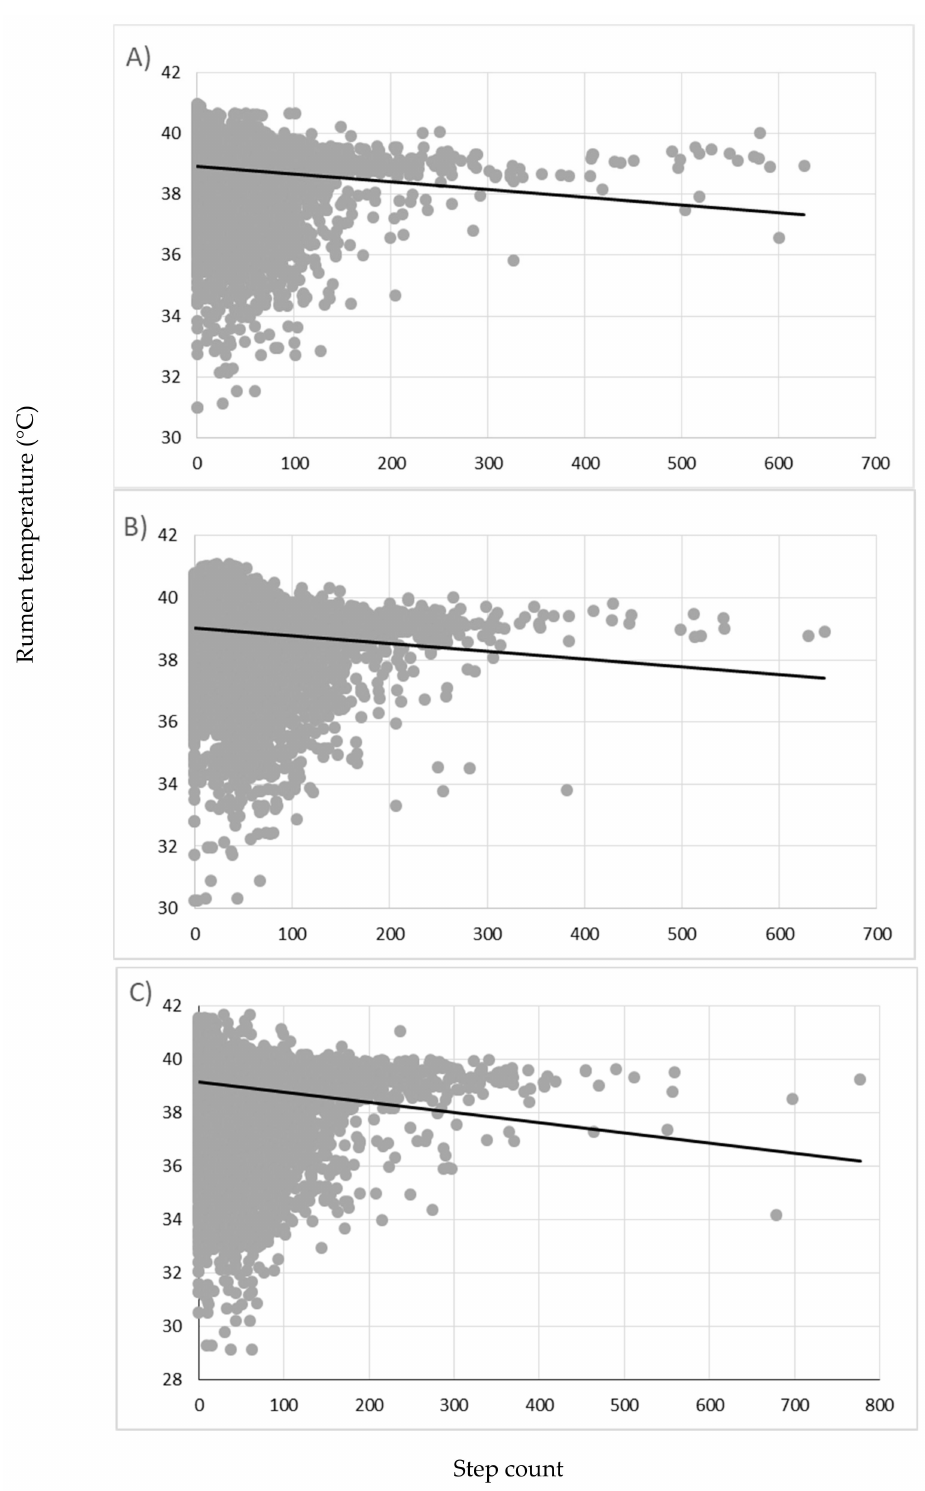
Figure 4. The e ff ect of step count on the rumen temperature of bulls on three di ff erent diets; ( A ) grazed only, ( B ) grazed with 2 kg concentrate supplementation, and ( C ) grazed with ad libitum access to concentrates. ( A ) y = -0.002534 χ + 38.85 a ( B ) y = -0.002456 χ + 38.99 a ( C ) y = -0.004077 χ + 39.06 b . a, b represent significant di ff erences between the interaction of step count and diet ( p <